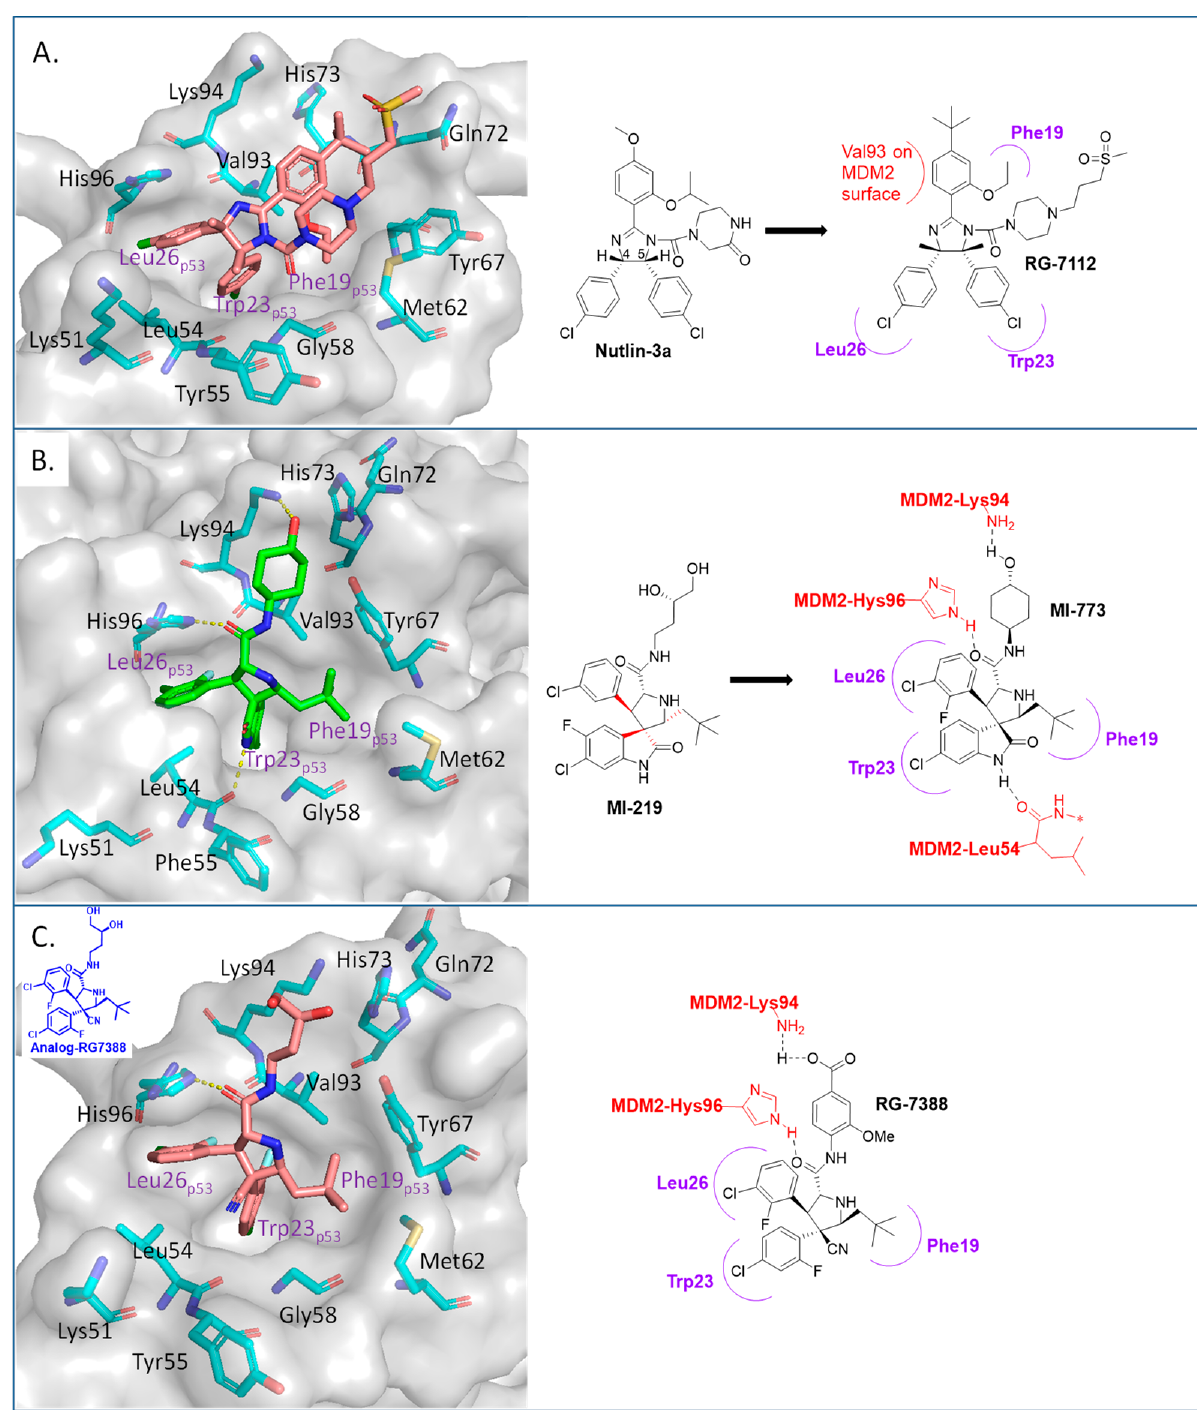
Figure 3. Co-crystal structures and chemical structures of inhibitors bound to MDM2 protein: ( A ) RG7112; ( B ) MI-773; and ( C ) RG7388. Labels and semicircles in magenta indicate the binding pockets in MDM2 where the p53 residues Phe19, Trp23, and Leu26 bind. Labels in red indicate MDM2 res- idues.